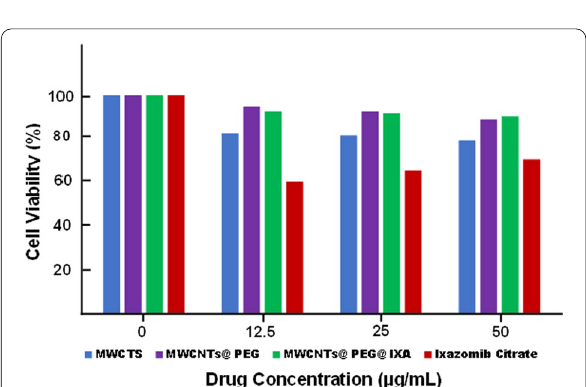
Fig. 9 Percent cell viability of RPMI8226 cells after treated with